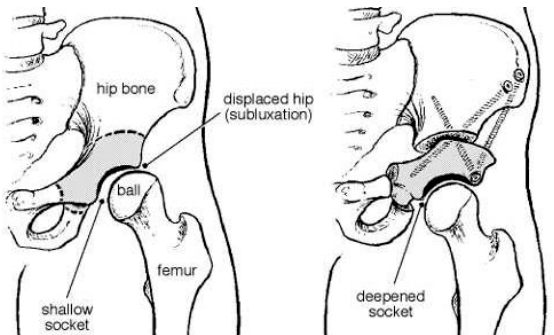
Figure 2. The PAO osteotomy—multiplane reorientation of the acetabulum.